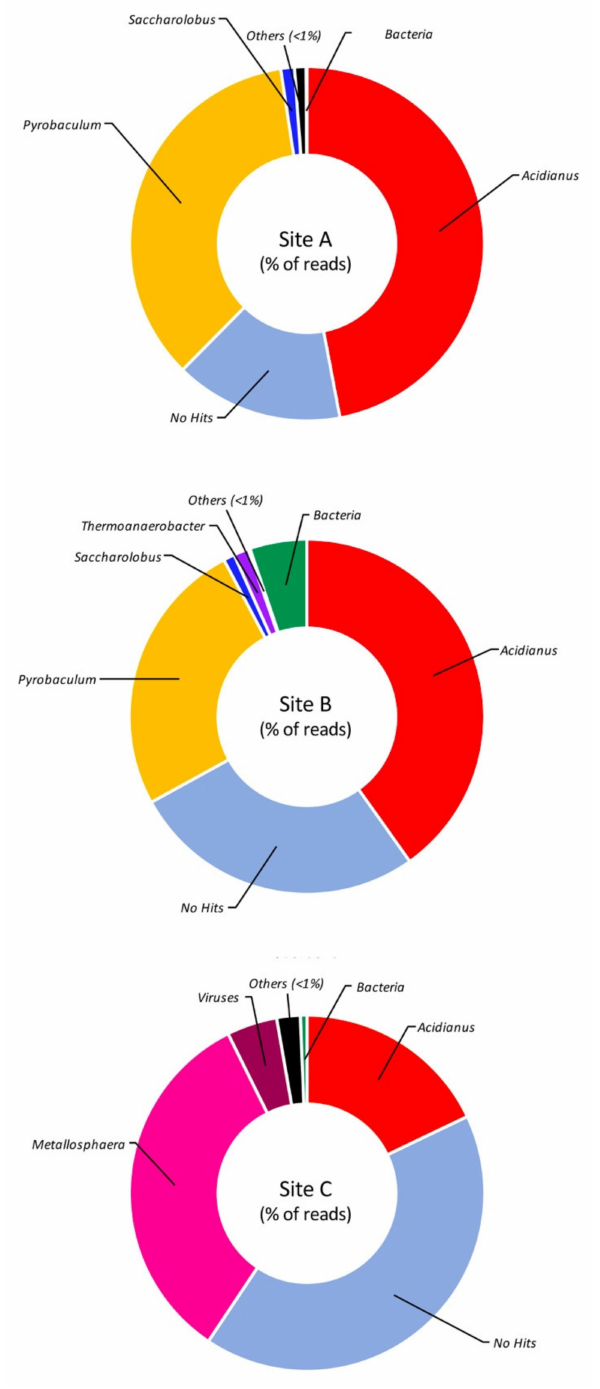
Figure 3. Taxonomic assignment of the reads at the genus level. Taxa showing less than 1% of assigned reads are grouped as